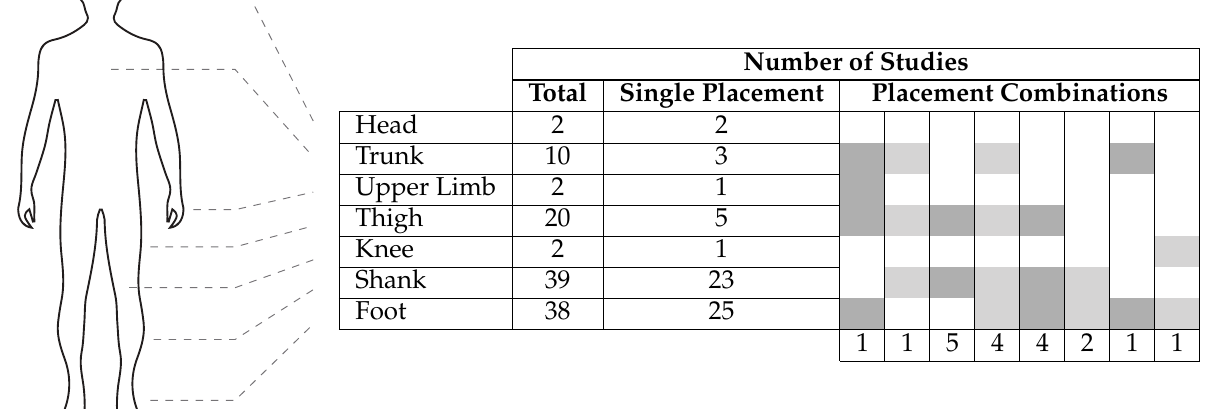
Table 4. Number of studies using inertial measurement units (IMUs) that placed the sensor(s) on specific anatomical locations. Single placement contains studies where sensor(s) were placed only in one anatomical location. Placement combinations’ columns indicate studies where sensor(s) were placed in more than one location. Each relevant location is marked by a shaded cell and the number of studies using this combination is indicated at the bottom of the column. The total indicates the sum of studies where the sensor(s) were placed on that given anatomical location.